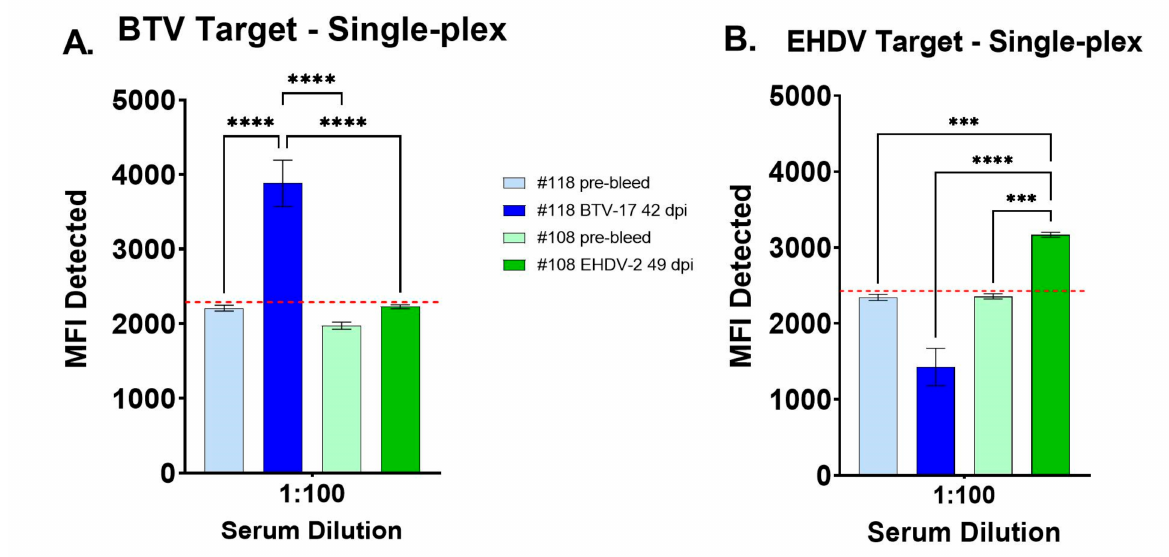
Figure 1. Mean fluorescence intensity (MFI) values of single-plex BTV and EHDV fluorescence microsphere immunoassays (FMIA) for pre-bleed and post-challenge cattle sera. ( A ) Single-plex BTV FMIA with sera from a BTV-17-inoculated cow (#118) at 42 days post-infection (dpi) compared to pre-bleed sera and sera from an EHDV-2-inoculated cow (#108) at 49 dpi. ( B ) Single-plex EHDV FMIA with sera from an EHDV-2-inoculated cow (#108) at 49 dpi compared to pre-bleed sera and sera from a BTV-17-inoculated cow (#118) at 42 dpi. One-way ANOVA with Dunnett’s multiple comparisons test and standard error; *** p < 0.001, **** p < 0.0001. Receiver operating characteristic (ROC) analysis followed by a Youden’s J Index was used to inform test cutoff value (red line) within the sera tested (BTV-target = 2288.46; EHDV-target =